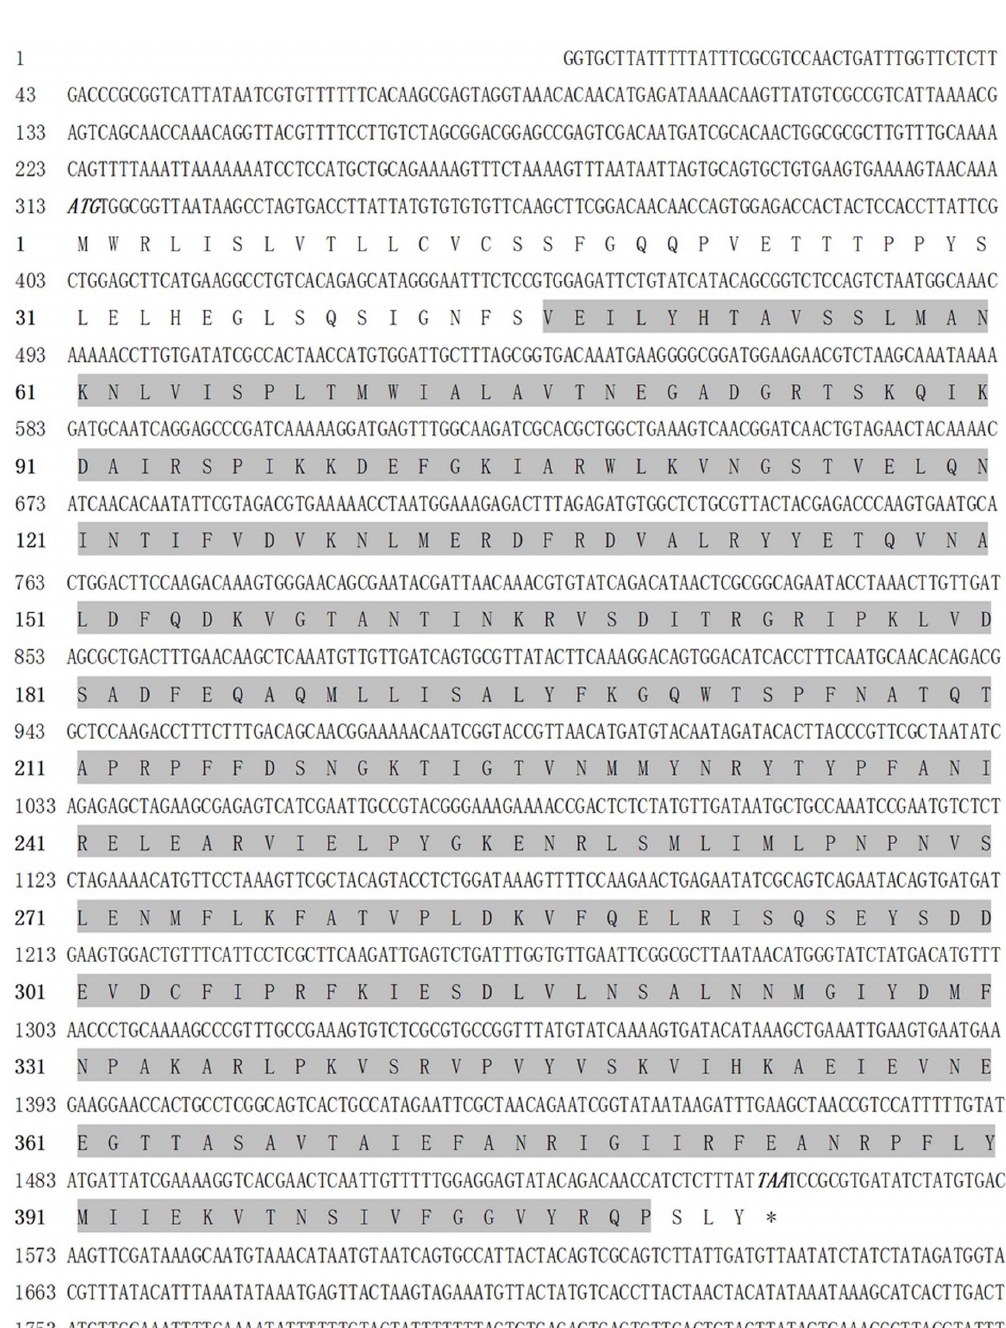
Figure 1. Nucleotide sequence (above) and deduced amino acid sequence (below) of the serpin-4 (GenBank accession No. KC686693). The serpin domain is shadowed. The asterisk (*) indicates the stop codon. Polyadenylation signal is bolded and italicized.